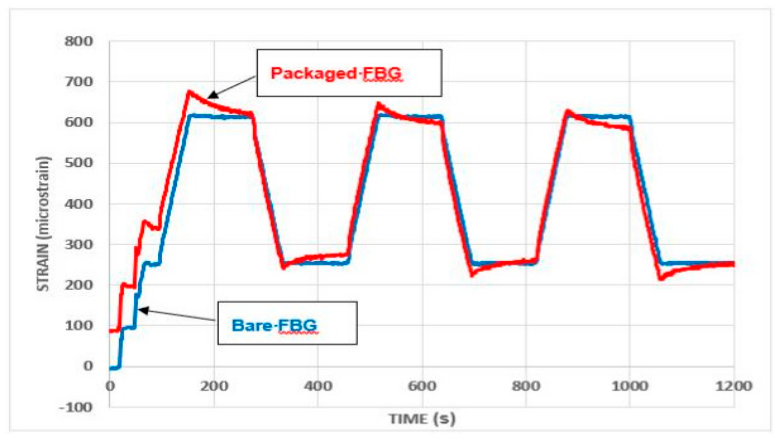
Figure 14. Open-top package: repeated load cycles to 5.0 kN (total load).